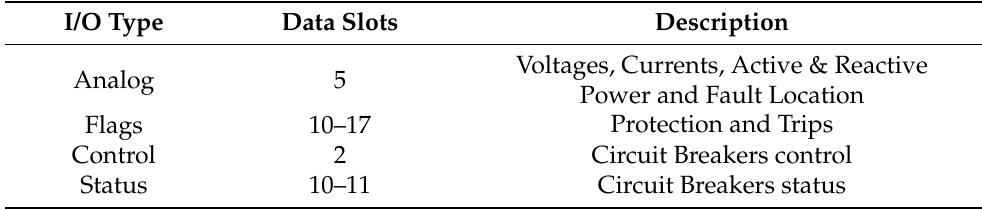
Table 4. ICCP data exchange scheme for